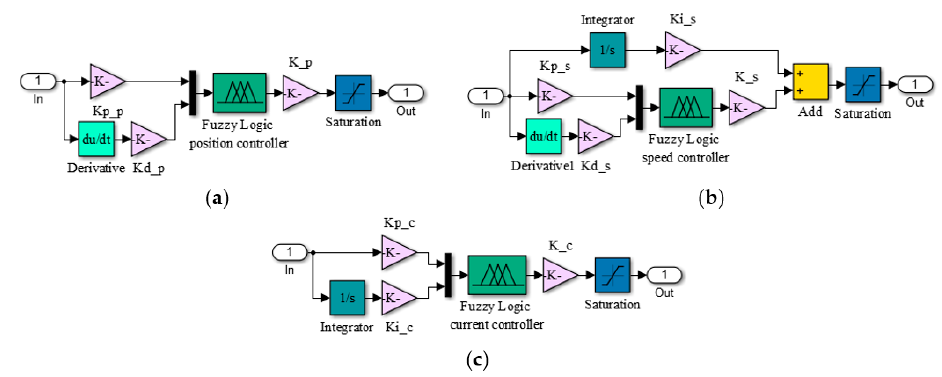
Figure 8. Structures of the controllers used in the three loops: ( a ) position, ( b ) speed, and ( c ) current.